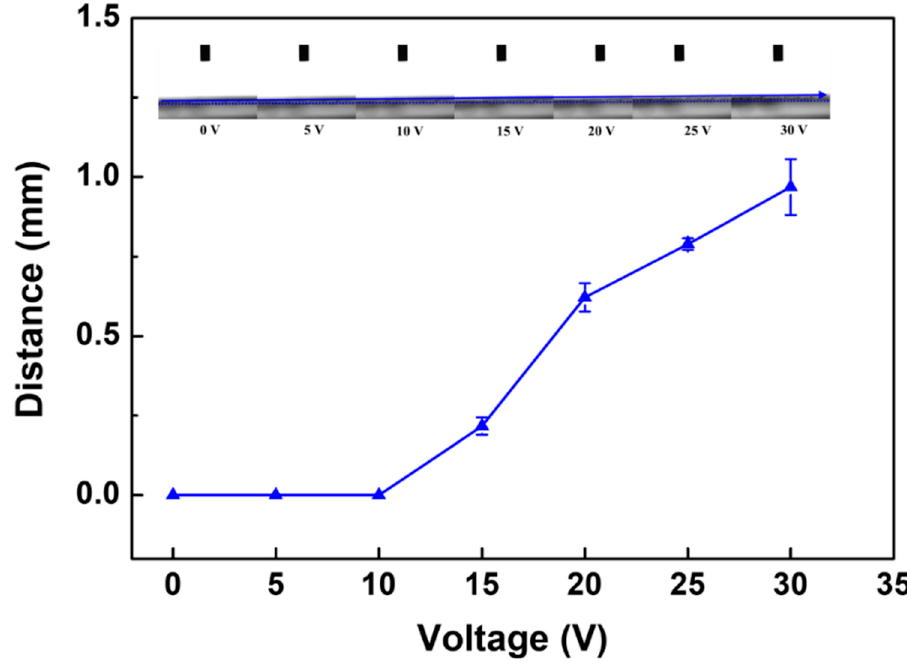
Figure 6. The deformation of PANI/EG composite membranes in response to the applied potential.